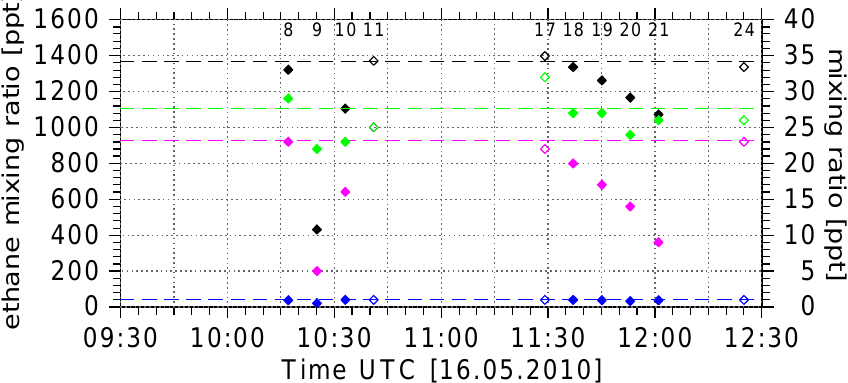
Fig. 6. Selected non-methane hydrocarbons (NMHCs) and perchloroethylene (PCE) measurements in whole air samples collected on 16 May 2010. Shown are ethane (black, left scale), n-butane (magenta, right scale), benzene (green, right scale) and PCE (blue, right scale). The whole air sample numbers are printed close to the upper margin. Open symbols denote samples outside the volcanic clouds, filled samples are from within the volcanic clouds. The dashed lines indicate the mean background concentrations outside the volcanic